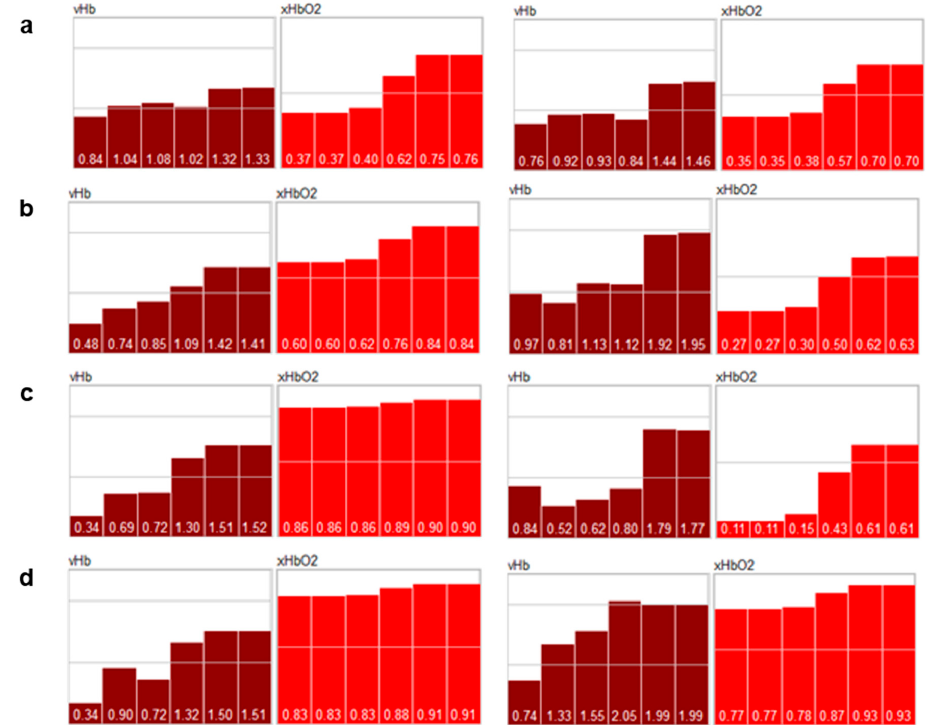
Figure 3. Perfusion profiles averaged over the test areas in Figure 1; the profiles depict the vHb- and HbO 2 -values for 6 depth layers (layer 3 in Figure 8 has been split into 2 layers 3.1 and 3.2) from left to right; the thickness of the layers are not depicted; vHb are index values [0 ... 2.5], xHbO 2 : [0...1]; left column: reference hand; right column: test hand; ( a ) normal perfusion, ( b ) venous occlusion, ( c ) arterial occlusion, ( d ) reperfusion after arterial